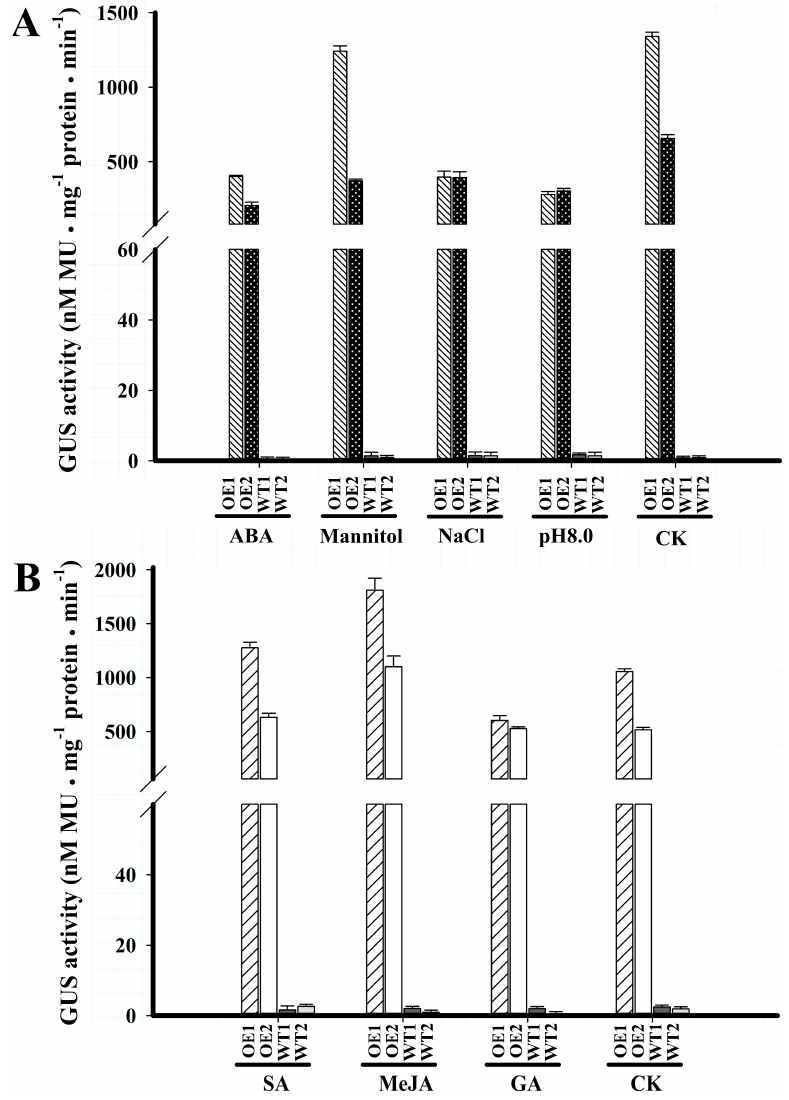
Figure 4. GUS activities of T 3 seedlings of Arabidopsis plant transformed with full-length BvcPPOP in the presence of abiotic stress signals. Data are shown as the mean value ± SD of three replicates of each BvcPPOP-GUS transgenic line. ( A ) Set 1 abiotic stress signals; ( B ) Set 2 abiotic stress signals.